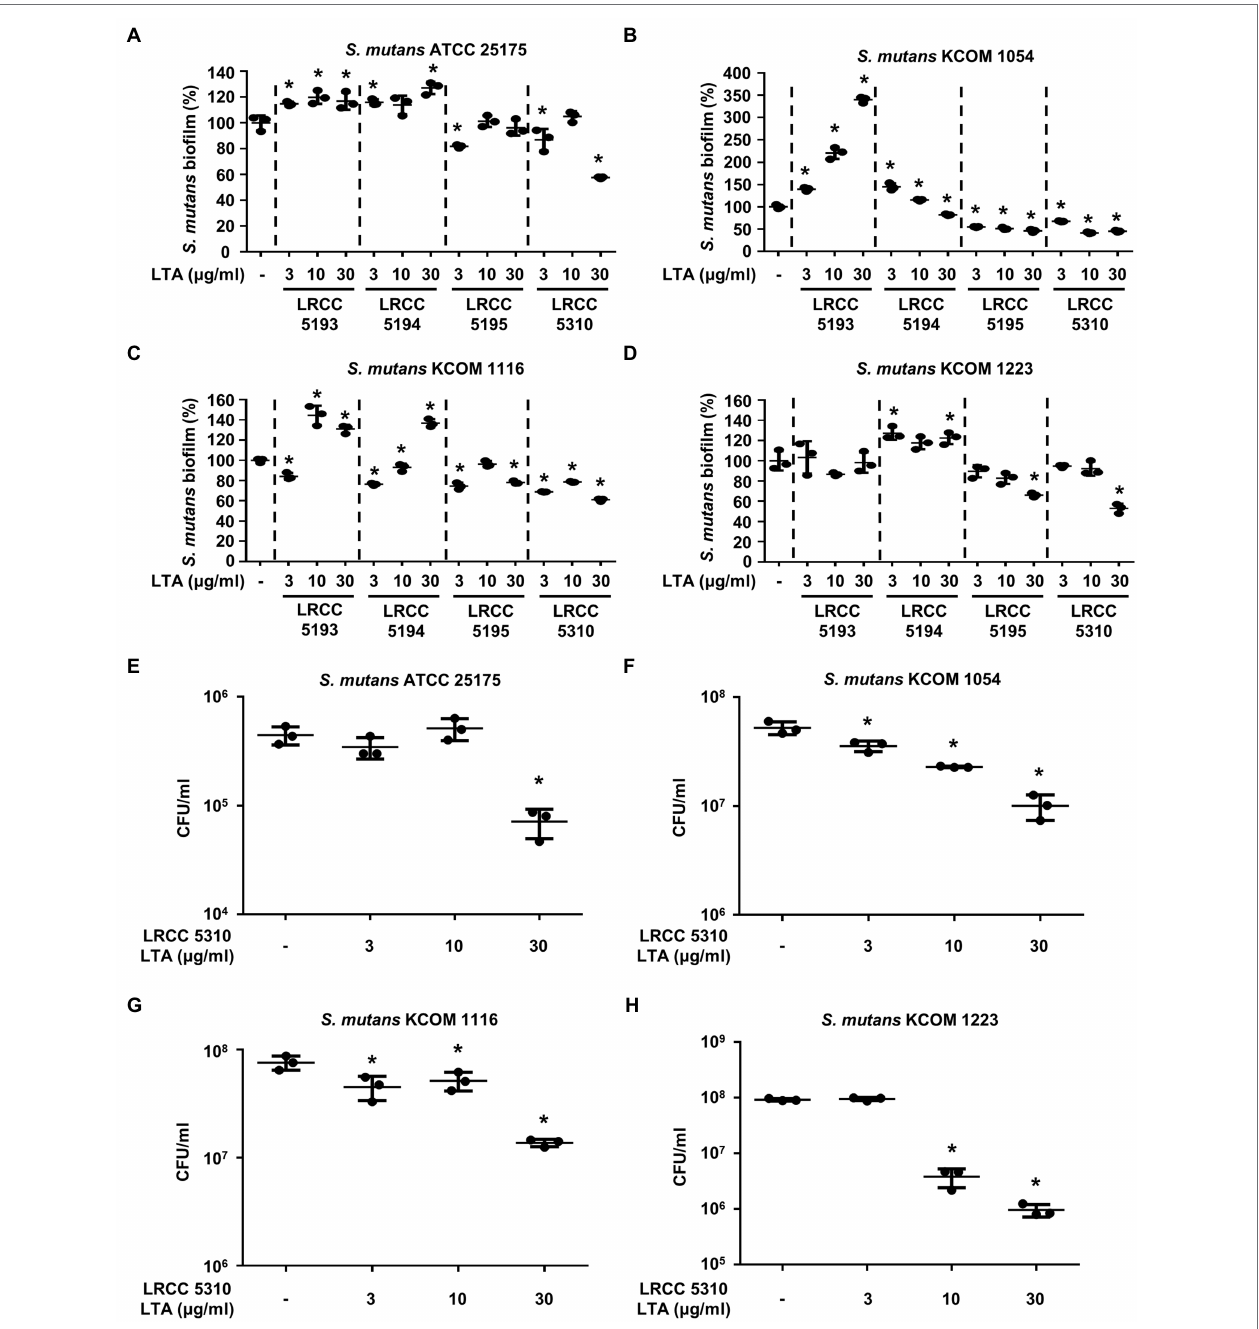
FIGURE 4 | Lp.LTAs differently suppress S. mutans biofilm formation. Four different strains of S. mutans , including (A,E) a laboratory (ATCC 25175) and (B–D,F–H) three clinically isolated strains (KCOM 1054, KCOM 1116, and KCOM 1223), were grown on 96-well plates in the presence or absence of the indicated concentrations of (A–D) various Lp.LTA or (E–H) LRCC 5310 Lp.LTA at 37 ° C for 24 h. After the incubation, biofilm formations were determined by crystal violet staining as described in Materials and Methods. Biofilm formation is presented as percentage change ± standard deviation of triplicates against the non-treatment group set as 100%. (E–H) After collecting the biofilm, it was serially diluted and incubated on the THY agar plate at 37 ° C for 48 h, and CFU formation was examined. Asterisk (*) indicates statistical significance at p < 0.05 between the non-treatment and each Lp.LTA treatment